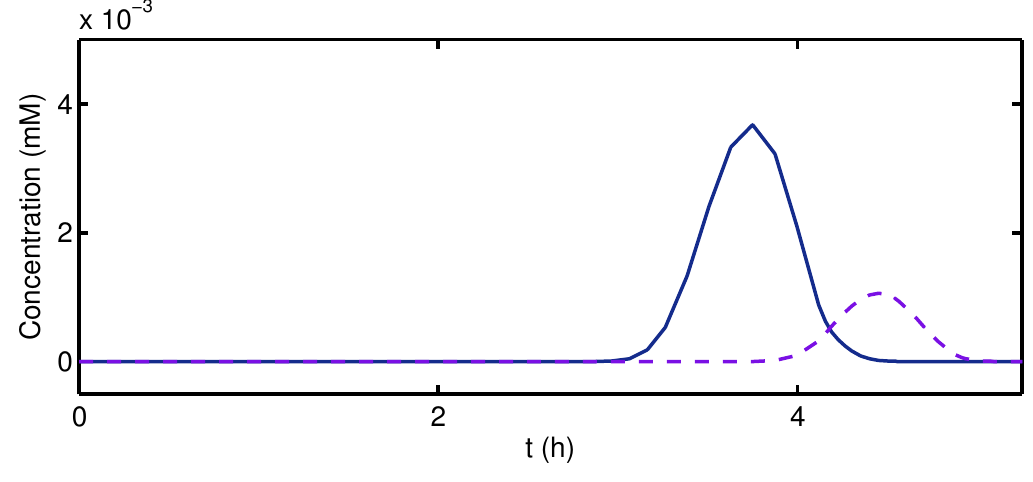
Figure 4. Chromatogram for the CIEX polishing and removal of aggregates during the batch-wise process. Solid line ( − ) is the monomers and dashed line ( −− ) is the ten times the dimers concentration.